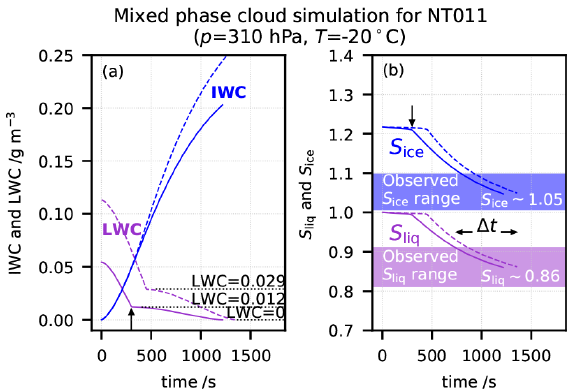
Figure 4. Modelling of the Wegener–Bergeron–Findeisen process in mixed-phase cloud demonstrating that flight NT011 likely encountered supercooled liquid droplets. Solid lines: lower estimate of liquid water content (LWC). Dashed lines: upper estimate (see text). Initial size distributions for lower estimate simulation: n ice = 0.02cm − 3 , r ice = 10µm; n liq , 1 = 10cm − 3 , r liq , 1 = 10µm; n liq , 2 = 0.003cm − 3 , r liq , 2 = 100µm. Initial size distributions for upper estimate simulation are identical but with 50% larger n liq , 1 and n liq , 2 . (a) Blue lines: ice water content (IWC); purple lines: LWC; (b) blue lines: ice saturation ratio ( S ice ); purple lines: liquid water saturation ratio ( S liq ) for lower and upper estimates. Glaciation times of small droplets τ g , 1 ∼ 6min, of big droplets τ g , 2 ∼ 17min. Shaded-saturated ratios: observed ranges from Fig. 3. Vertical arrows: time when smaller liquid droplets fully evaporated. The computed time interval with S ice and S liq matching flight observations is (cid:49)t ∼